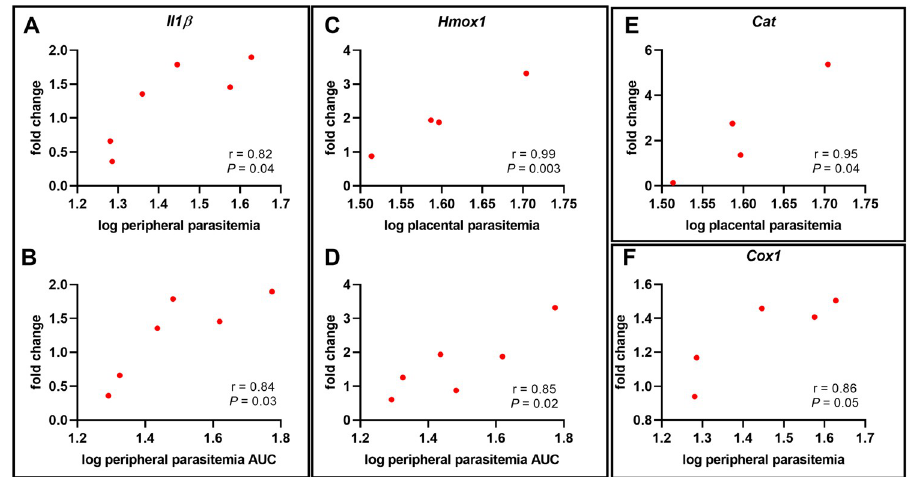
Fig 6. Inflammatory and antioxidant gene expression in the E15.5 placenta positively correlates with peripheral and placental parasitemia in mice infected on E6.5. (A-F) Mouse mRNA transcript abundance relative to peripheral